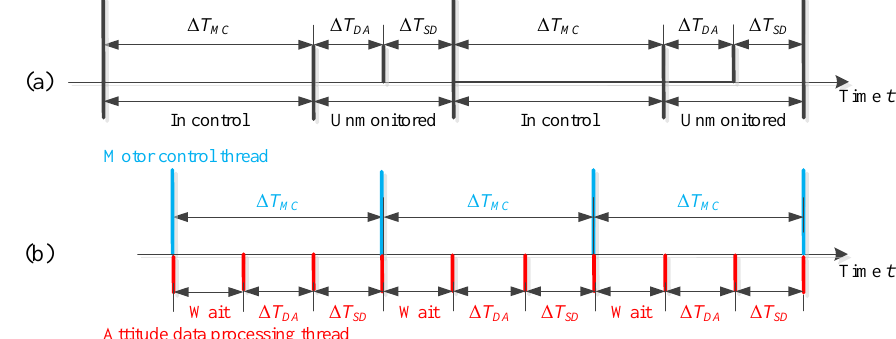
Figure 5. ( a ) Serial and ( b ) parallel implementation of the attitude data acquisition, processing, and motor control. ∆ T MC represents the period the motor control command is sent and executed; ∆ T SD represents the period to collect the transmitted attitude data from Arduino; ∆ T DA is the period required for the host PC to process the transmitted data.